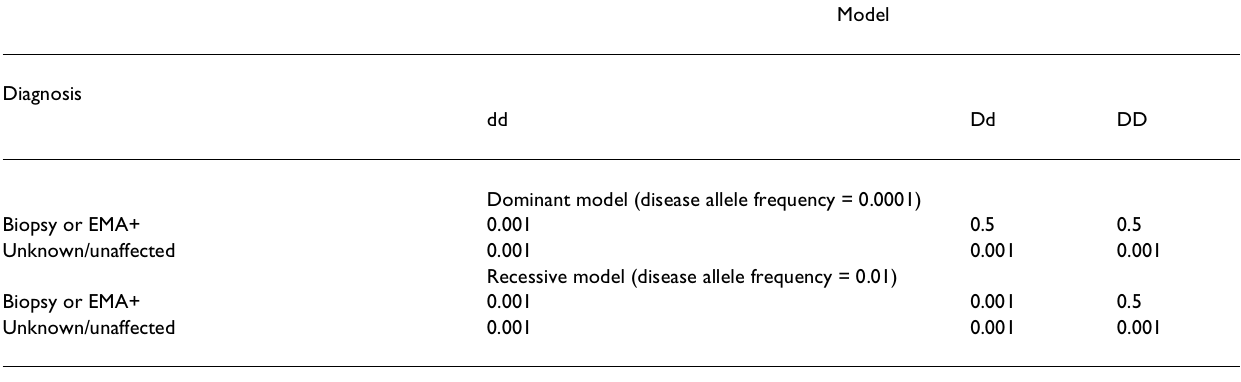
Table 3: Models used in the analysis with penetrance classes by diagnostic class (D = disease